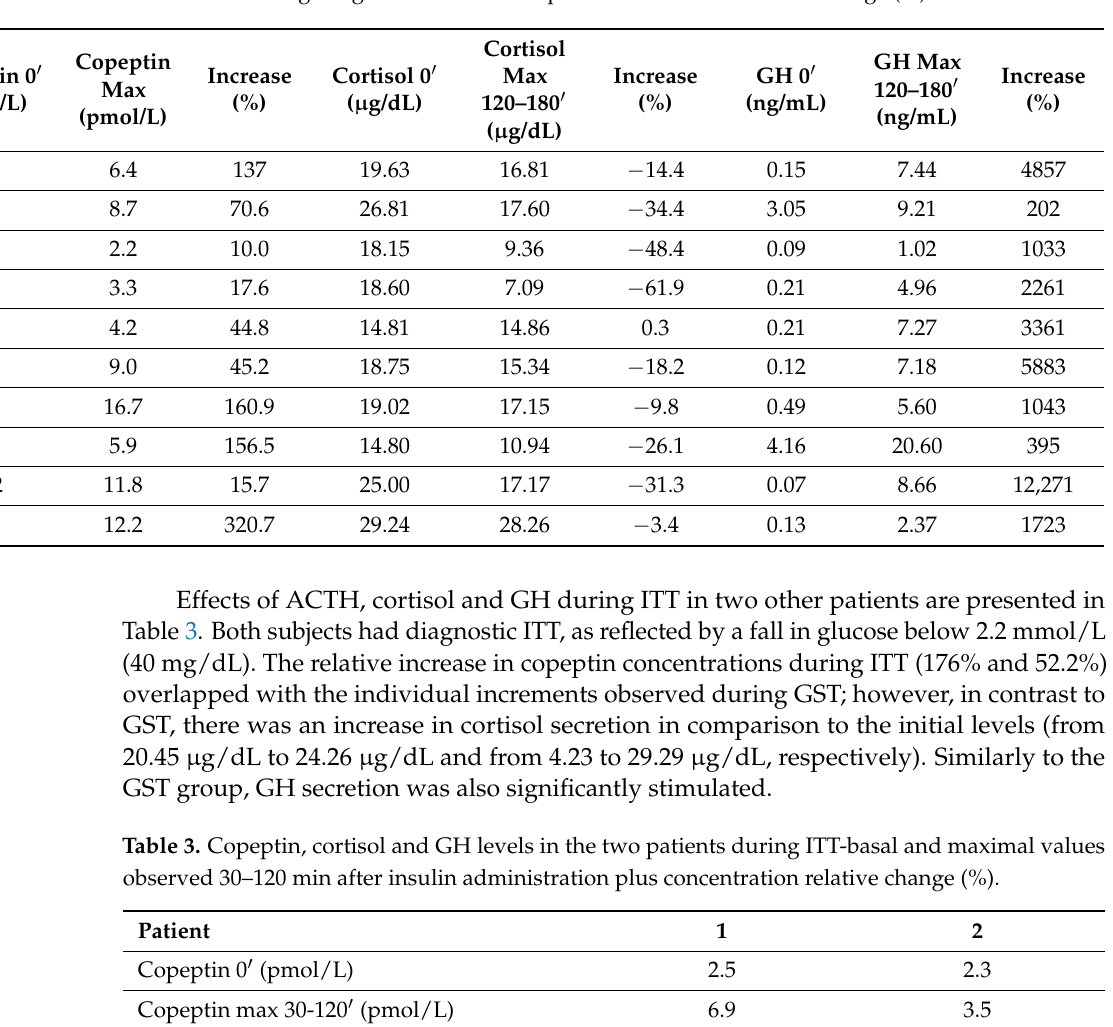
Table 2. Copeptin, cortisol and GH levels in patients during GST-basal and maximal values observed 120-180 min after glucagon administration plus concentration relative change (%).